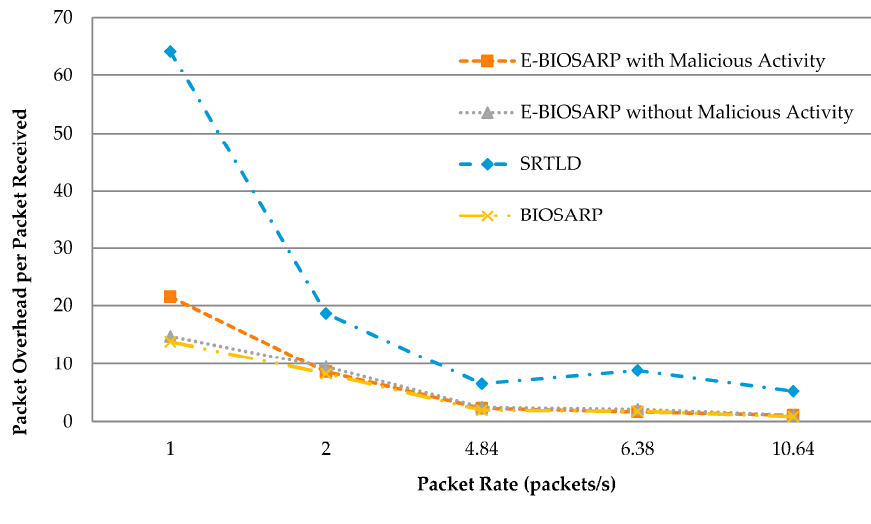
Figure 13. Packet overhead comparison.